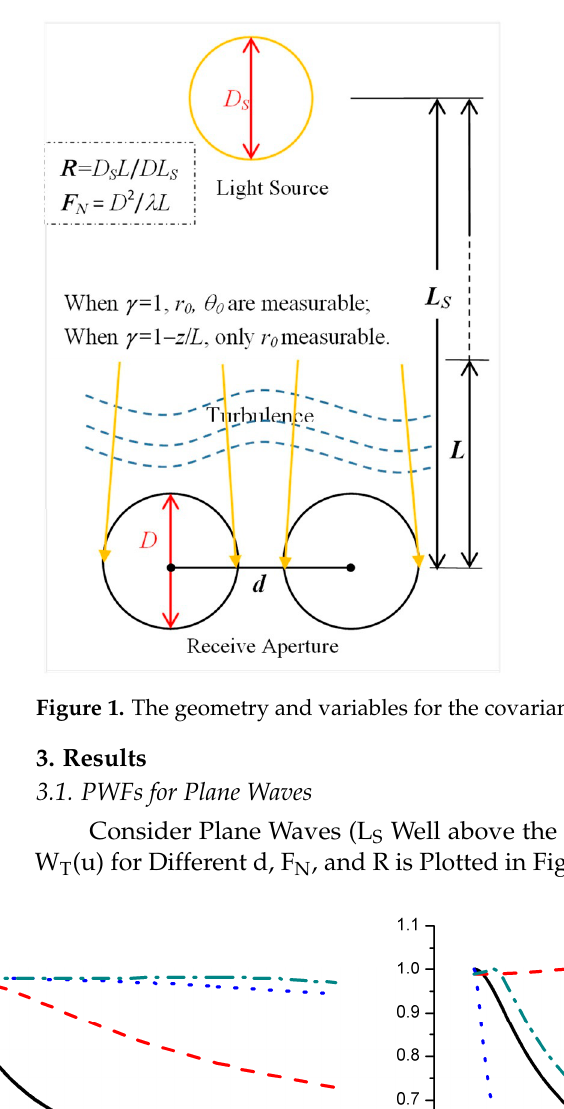
Figure 3. Normalized path-weighting function W P ( u ) for the covariance of piston amplitude for plane waves. ( a ) Point sources with various F N ( F N = D 2 / λ L ) and d (the distance between the aperture centers) values. ( b ) Distributed sources with various R ( R = D S L/DL S ) and d values when F N = 1. For a point source such as a star, for which R = 0, the W P ( u ) for different F N and d values is shown in Figure 3a. It can be seen immediately that the asymptotic behavior of the W P ( u ) for d = 0 with respect to F N is consistent with well-known asymptotic behavior [5], i.e., the PWFs of stellar scintillations ( W P ( u ) for d = 0) are approximate to u 5/6 for a small D (i.e., small F N when λ L is fixed) and u 2 for a large D . When the selected F N is sat- isfactory (approximately equals one, dash line), the W P ( u ) for d = 0 is approximate to u 5/3 , which is needed to calculate the isoplanatic angle [5,6]. In Figure 3a, there is a remarka- ble place where the curves of W P ( u ) for d = 0.5 D , F N = 1 and d = 0 D , F N = 5 seem almost identical, both approximating u 2 , which is needed to calculate the tilt isoplanatic angle ( θ TA ) [1,3]. For a distributed source such as the sun or a planet, the W P ( u ) for different R and d values with a fixed Fresnel number F N = 1 is shown in Figure 3b. It can be seen that the peak position of W P ( u ) with the same d value moves toward the start of the path with